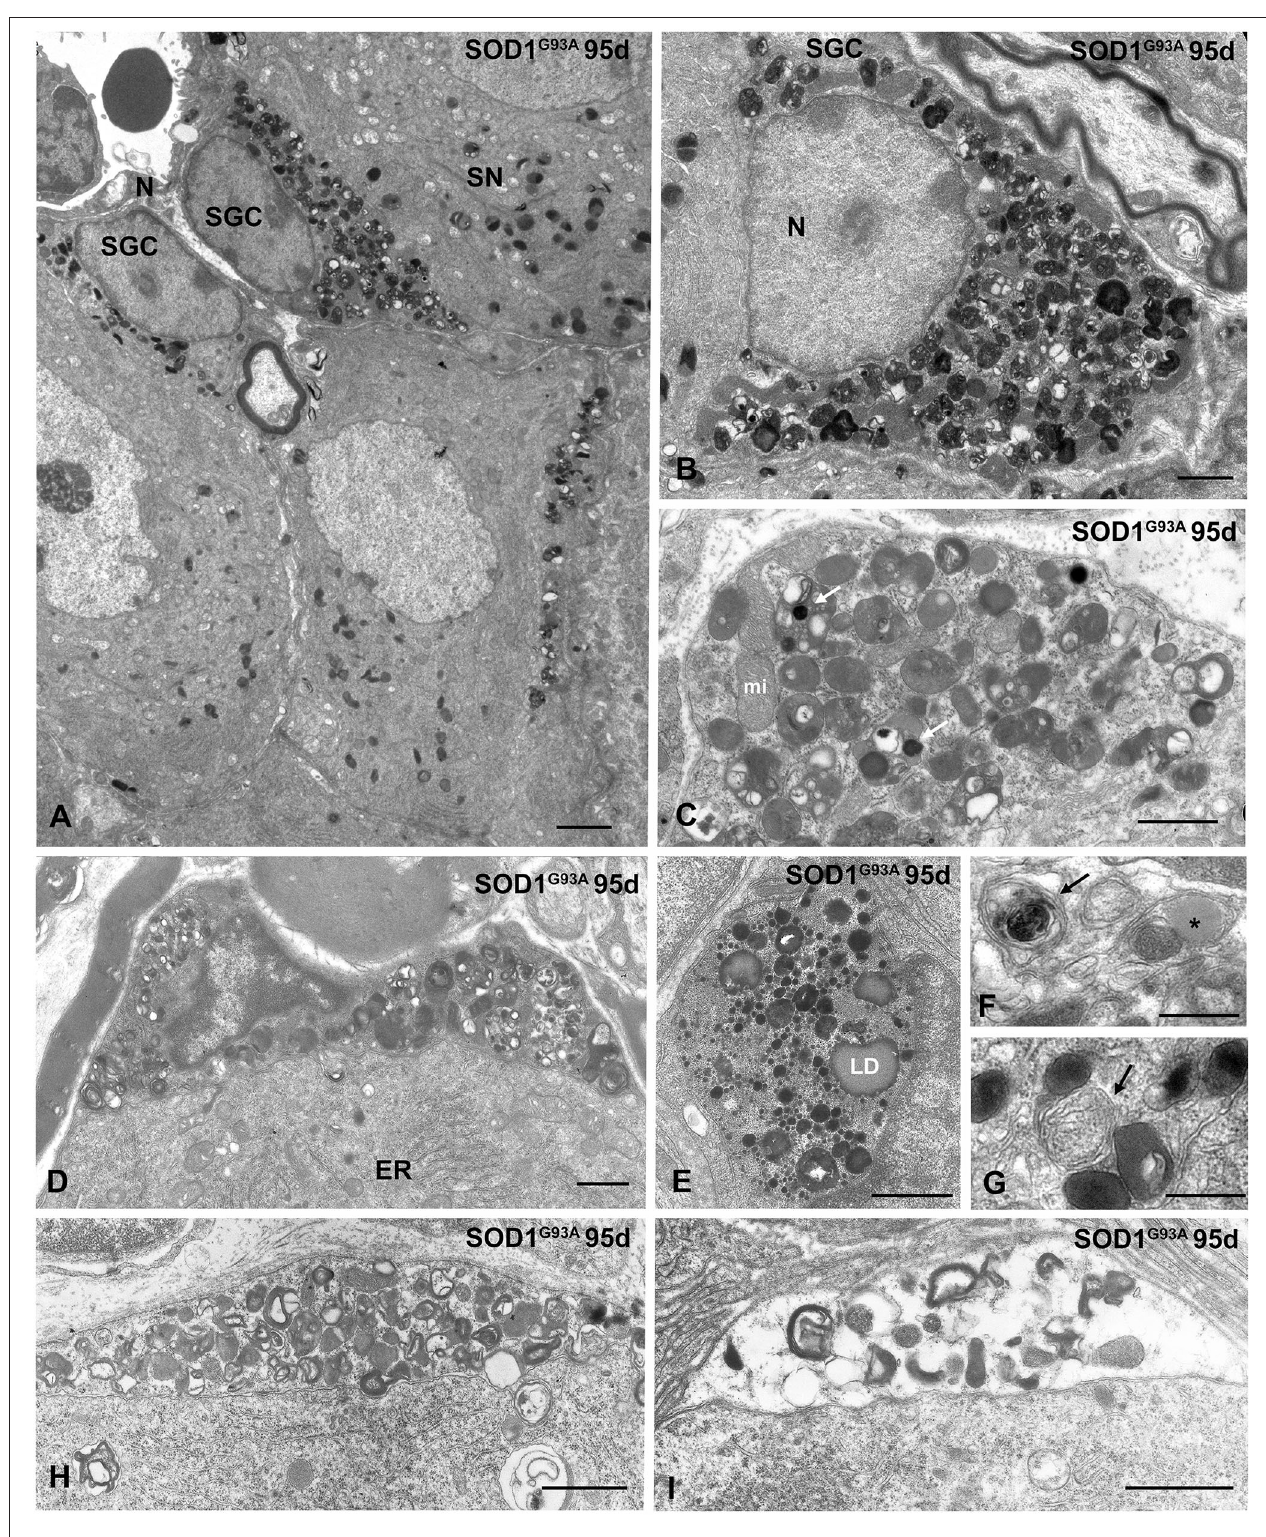
FIGURE 6 | Advanced lysosomal storage disorder in SGCs from SOD1 G93 mice at symptomatic stage (95 days of age). (A) Representative example of several SGSs from a SOD1 G93 mouse with lysosomal storage. One of the associated sensory neurons (SN) shows abundance of lysosomes and cytoplasmic vacuolation of